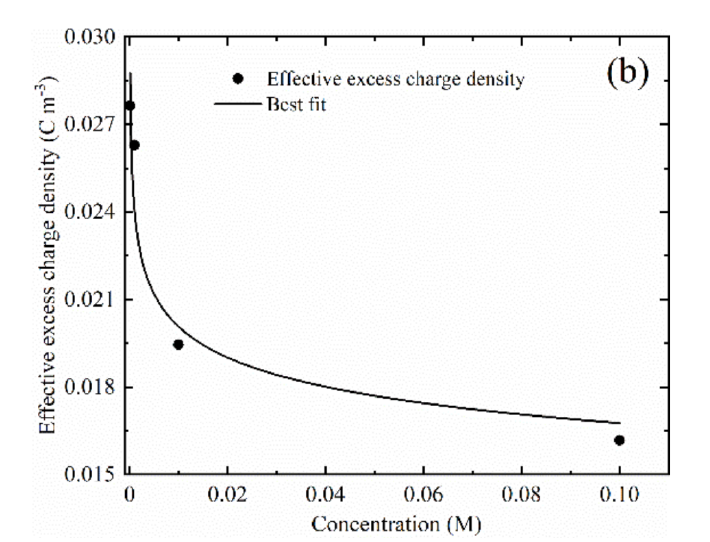
Figure 8. The empirical relationship between effective excess charge density and compactness and concentration. ( a ) The empirical relationship between effective excess charge density and compact- ness. ( b ) The empirical relationship between effective excess charge density and concentration.